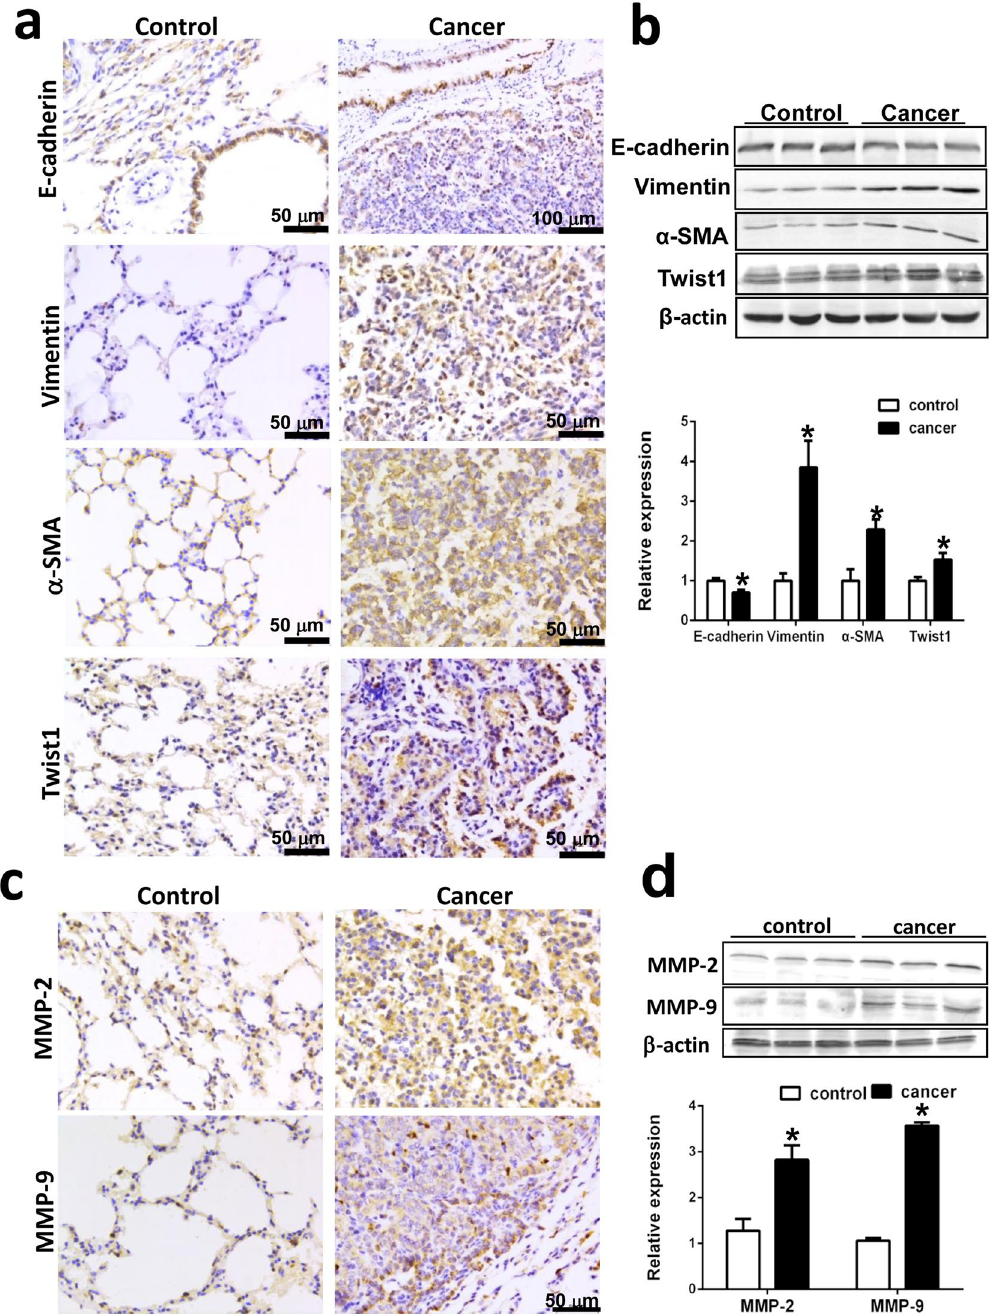
Figure 2. Epithelial-mesenchyme transition (EMT) is induced in AFG 1 -induced lung adenocarcinoma. Paraffin sections and the total protein samples isolated from the lung-adenocarcinoma or control lung tissues were collected from our previous study. ( a ) Representative immunohistochemical staining of E-cadherin, vimentin, α -SMA and twist1 in AFG 1 -induced lung adenocarcinoma. ( b ) The expression of E-cadherin, vimentin, α -SMA and twist1 at protein level was shown by Western blot. Band intensity is coming from densitometry, and data was shown as mean ± SD (n = 3, * p < 0.05, compared to control group). ( c ) Representative immunohistochemical staining of MMP2 and MMP9 in AFG 1 -induced lung adenocarcinoma. ( d ) The expression of MMP2 and MMP9 at protein level was shown by Western blot. Band intensity is coming from densitometry, and data was shown as mean ± SD (n = 3, * p < 0.05, compared to control